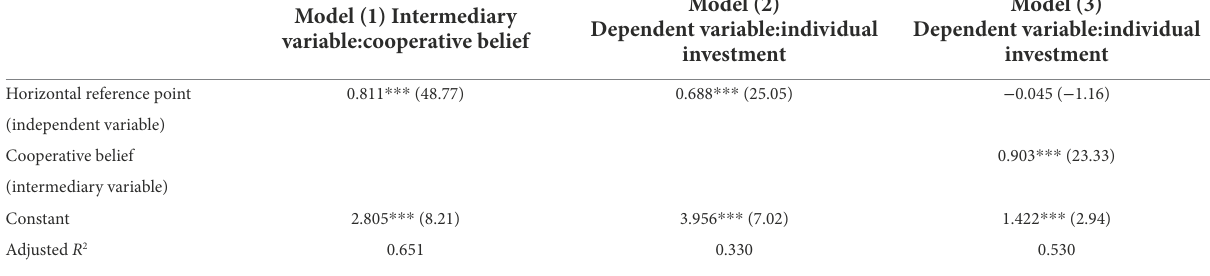
TABLE 10 Regression results of intermediary model of horizontal reference point of investment-cooperative belief-individual investment. Model (1) Intermediary variable:cooperative belief